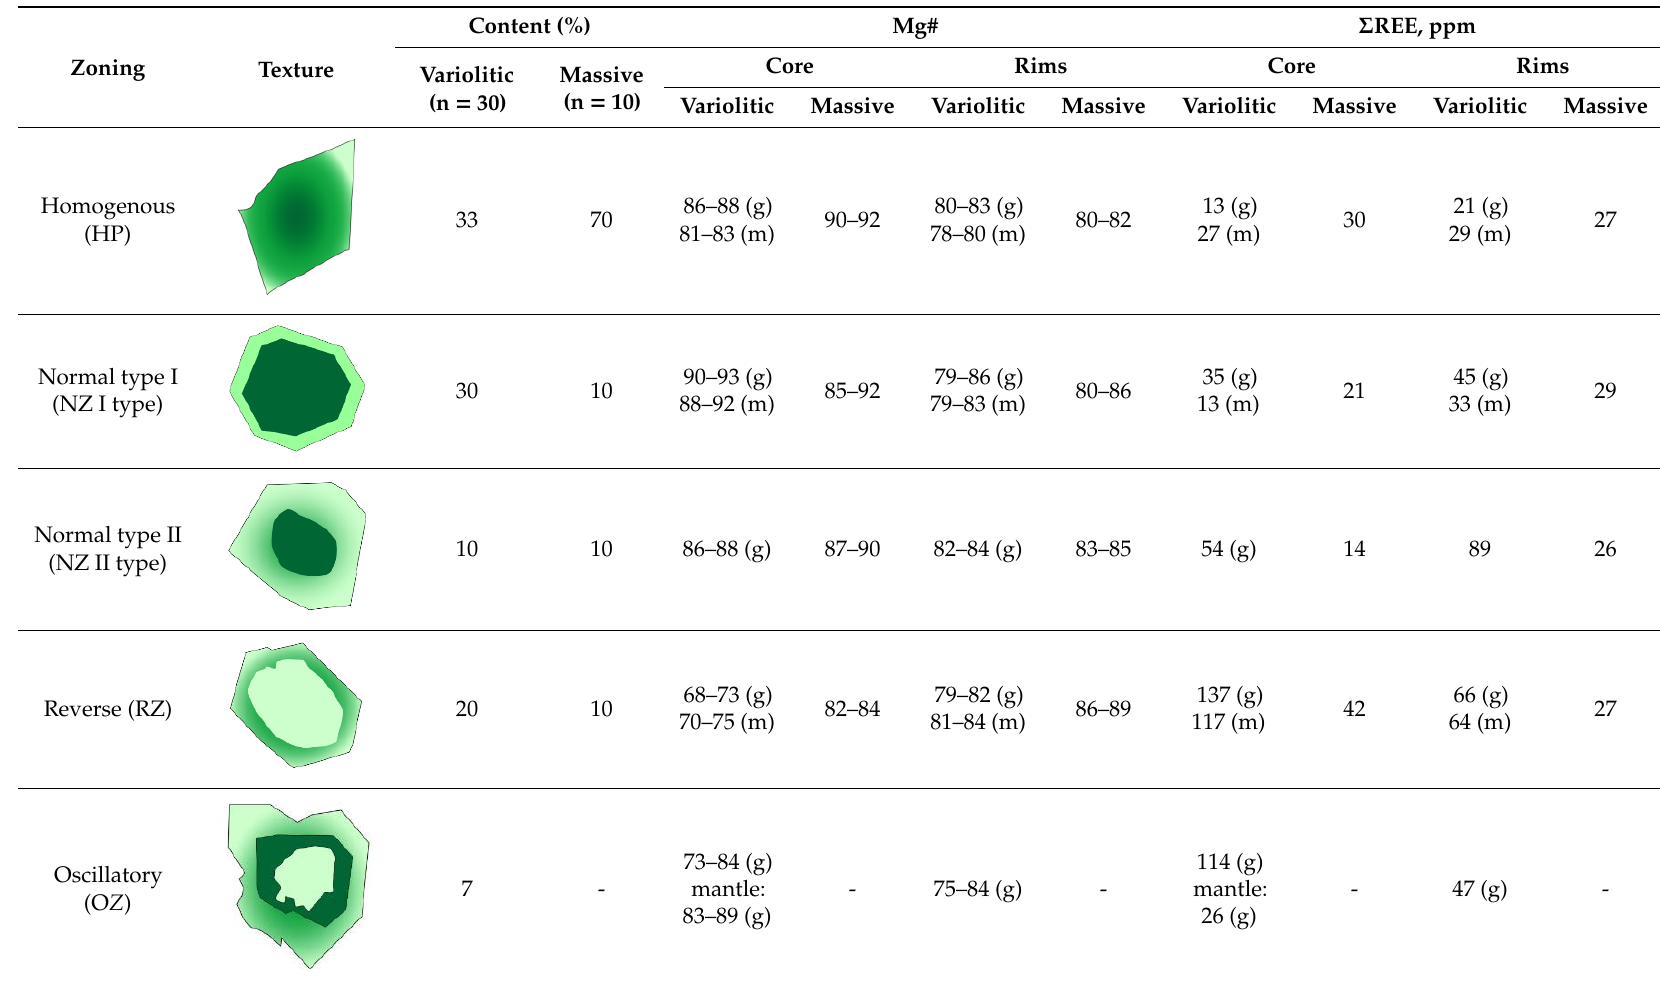
Table 1. Summary of zoning patterns, textures, and chemical characteristics of clinopyroxene phenocrysts from the variolitic and massive lavas of Yalguba Ridge. Notes: